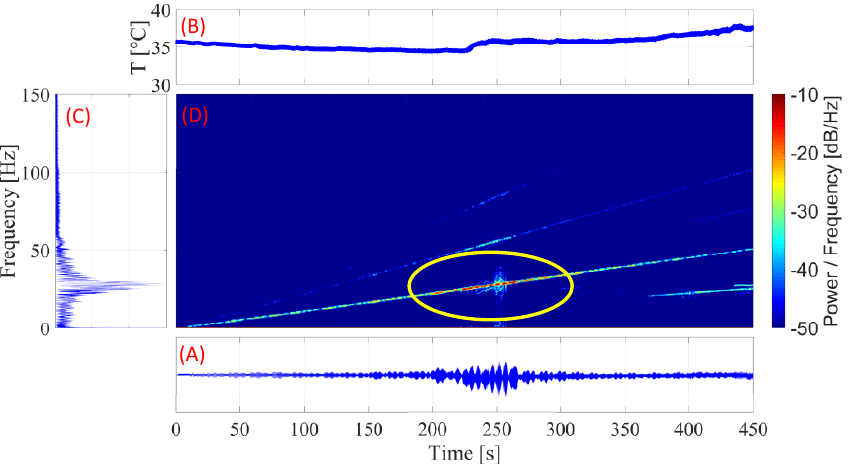
Figure 14. Curve for the SMA-SE M-Shape device without pre-load: ( A ) amplitude (peak to peak) × time; ( B ) temperature × time; ( C ) FFT; ( D ) spectrogram.